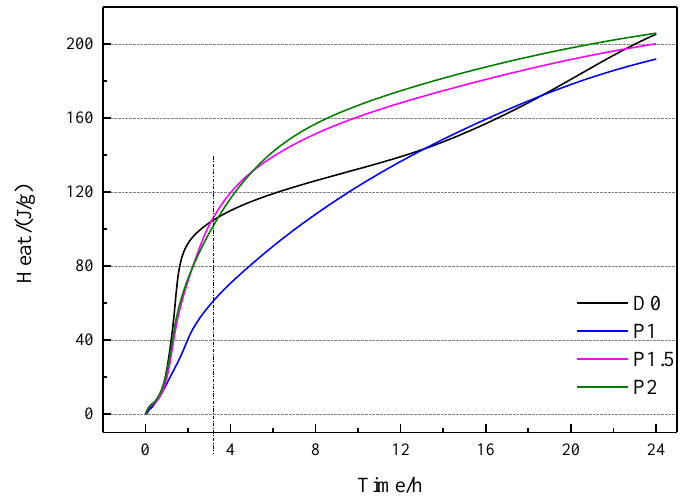
Figure 8. The hydration heat of composite cement.